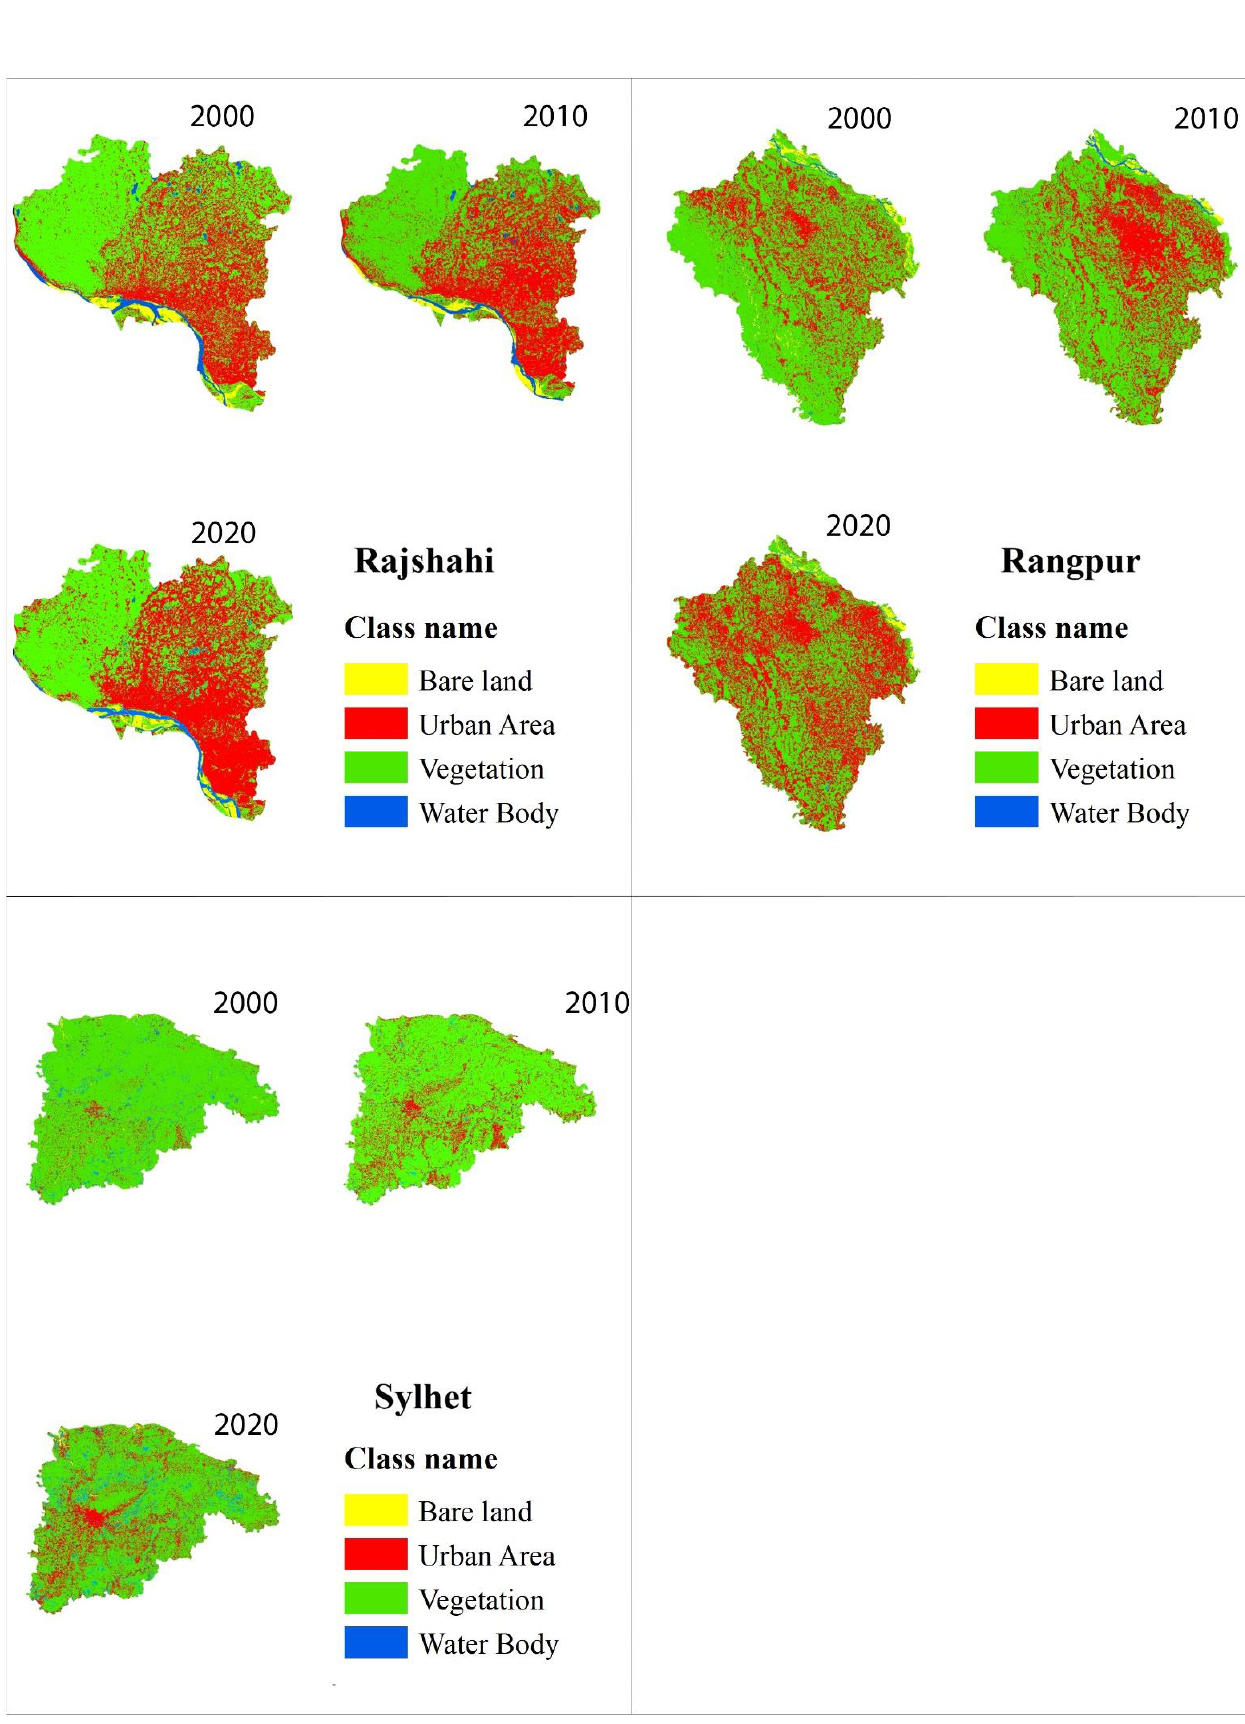
Figure 4. Spatiotemporal distributions of LULC in seven districts of Bangladesh.